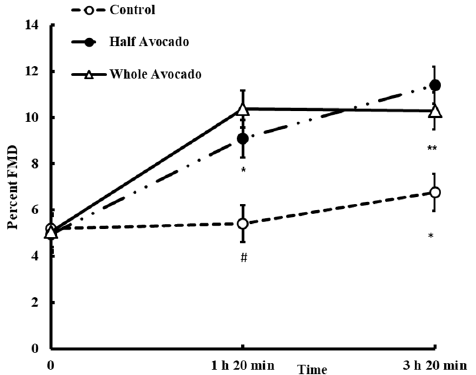
Figure 4. Flow-mediated vasodilation responses over 6 hours after consuming study meal. The figure legend indicates test meal groups ( n = 23). Data were analyzed by PROC MIXED using SAS 9.4. Main effects of meal p =0.0002, time p < 0.0001, and meal by time p = 0.0018. Data are means ± SE, n = 23.